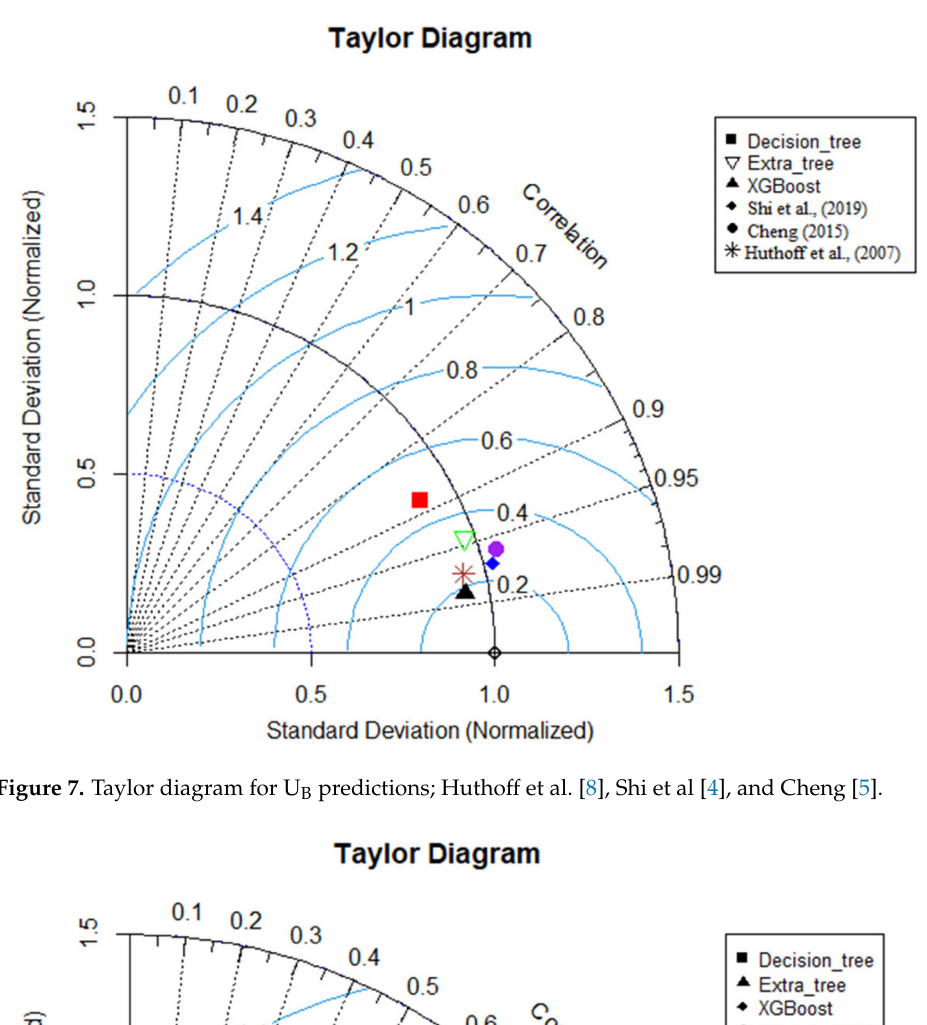
Figure 7. Taylor diagram for U B predictions; Huthoff et al. [8], Shi et al [4], and Cheng [5].